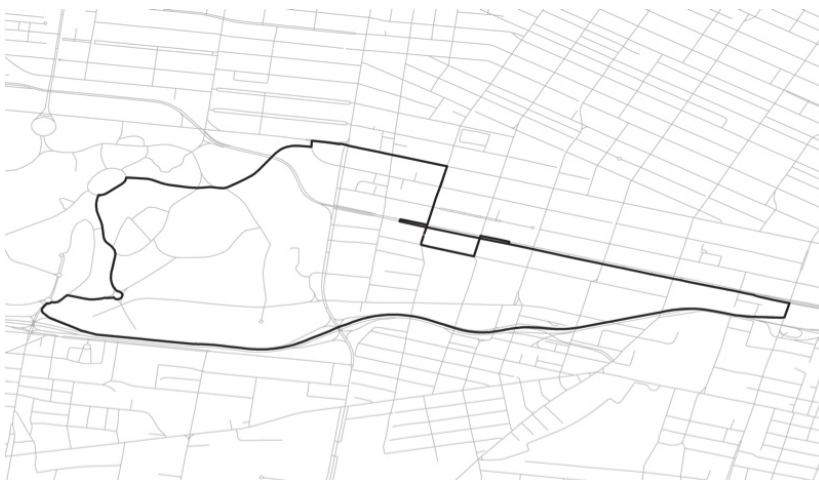
Figure 3. 1 minute AM